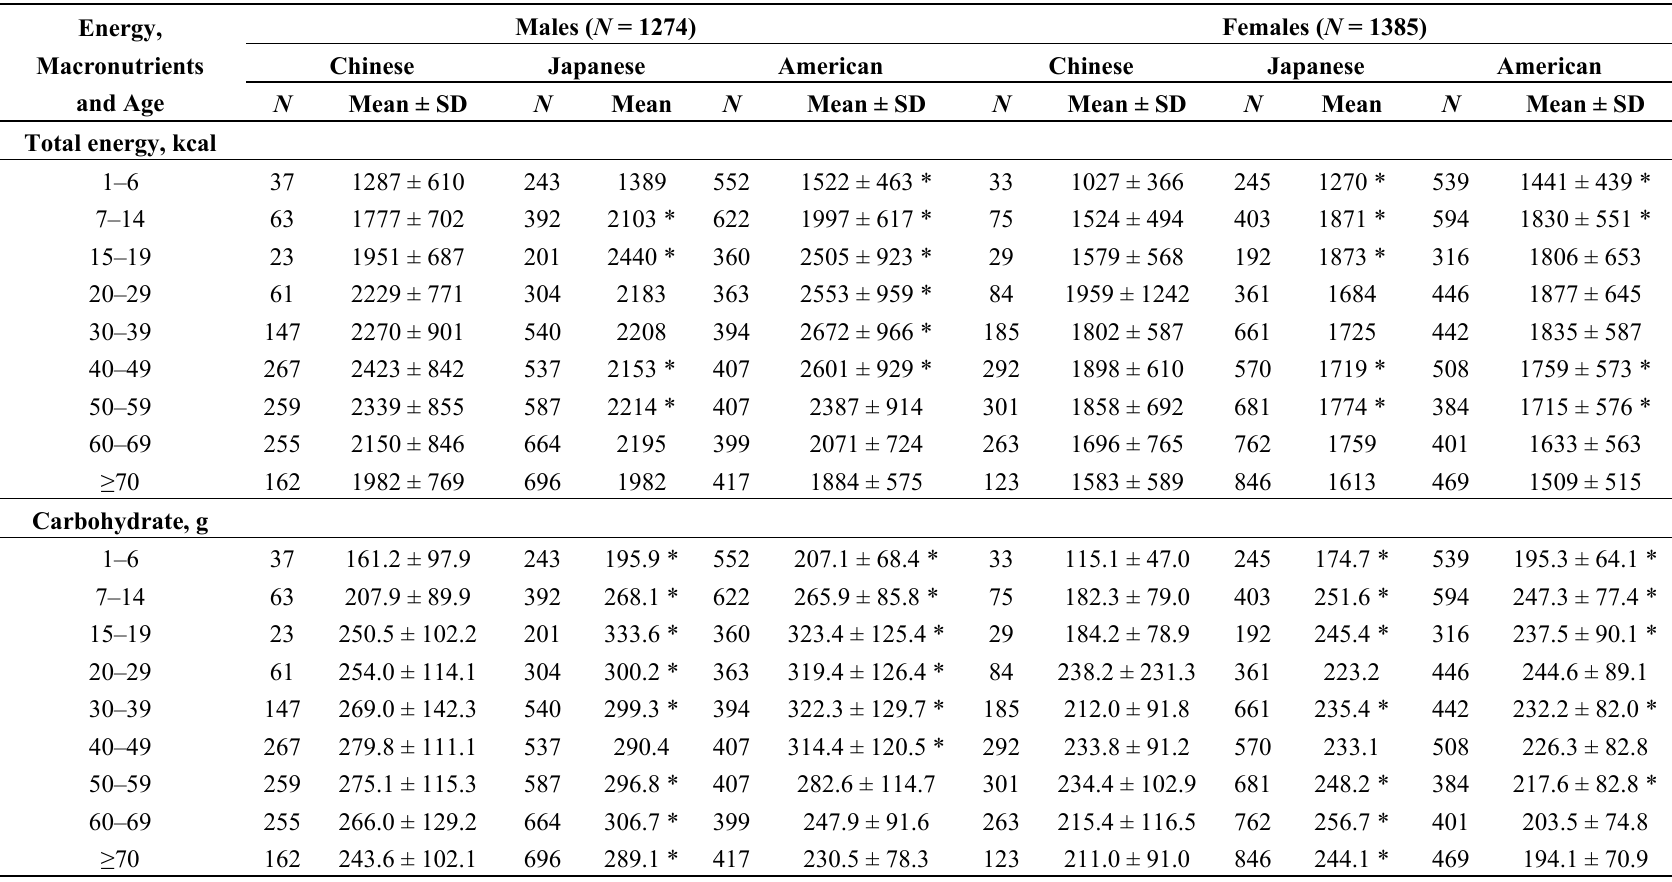
Table 2. Comparison of daily intake of energy and macronutrients by age and sex in the Chinese, Japanese and American groups.